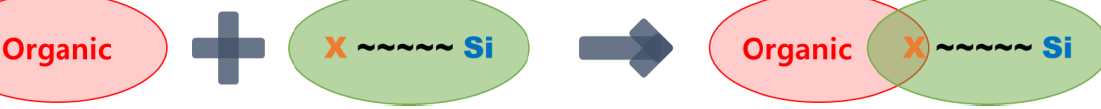
Figure 4. Silane coupling agent organic coupling reaction.